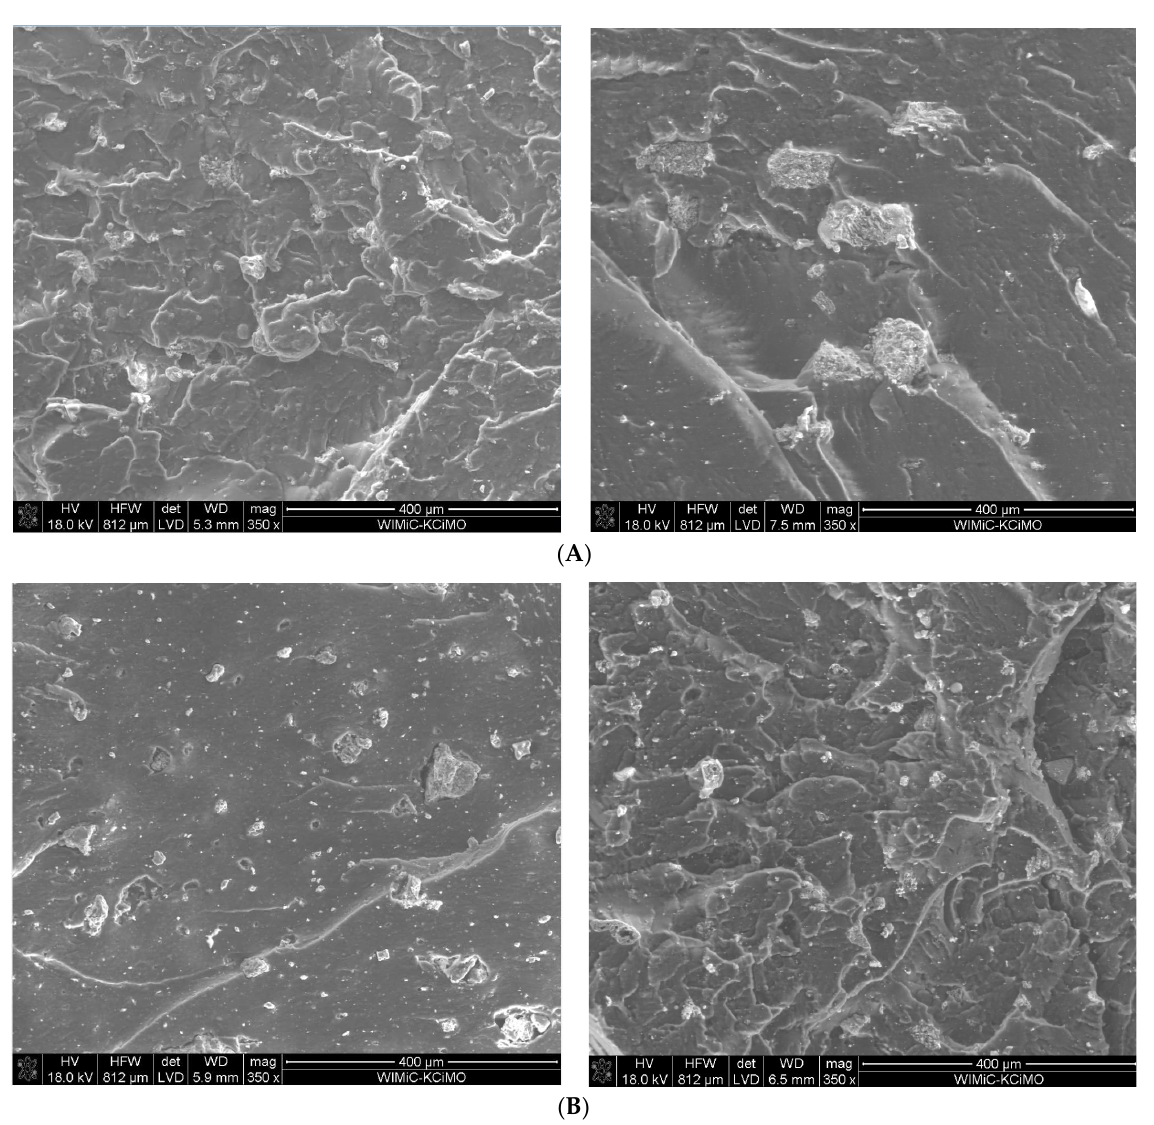
Figure 5. SEM pictures of the vulcanizates containing 30 phr of N 220 and 20 phr of fractionated fly ash (FA) with the addition of U-50 silane (left) or Si-266 silane (right) for: ( A ) FA-63 and ( B ) FA-125. The degree of dispersion of fillers containing carbon black and various fractions of fly ash treated with different silanes is summarized in Table 3. Table 3. Influence of silanization on the filler dispersion of rubber vulcanizates containing 30 phr of N 220 and 20 phr of the fractionated fly ash. Filler System + Silane